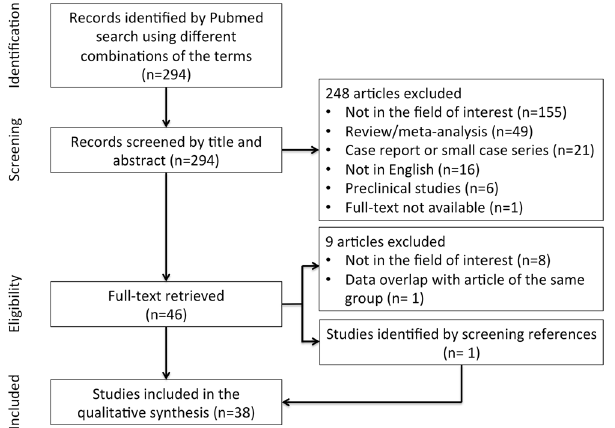
Figure 1. Schematic representation of the process of selection of literature data included in the